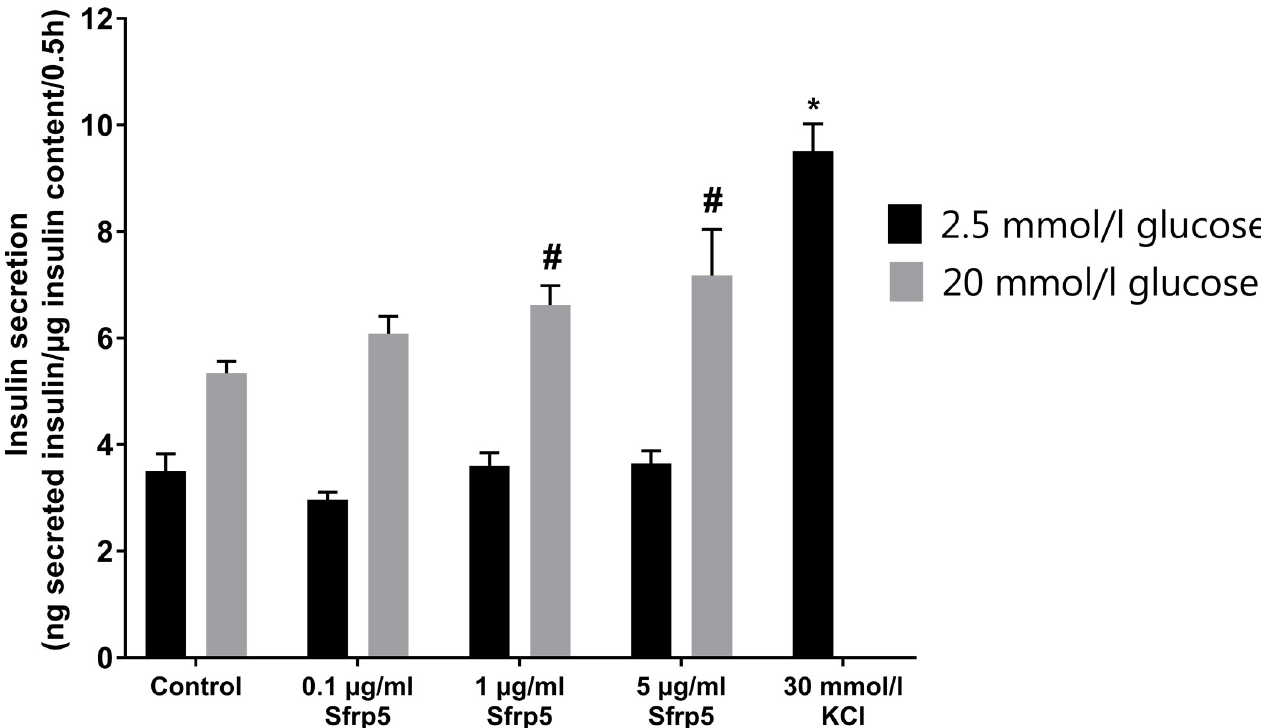
Fig 2. Sfrp5 and insulin secretion. Effect of different concentrations of Sfrp5 on basal and glucose-stimulated insulin secretion of INS-1E cells (N = 5). KCl was the positive control for increased insulin secretion. Data are presented as mean + SEM. #, p < 0.05 vs. control (20 mmol/l glucose); ��� , p < 0.001 vs. control (2.5 mmol/l